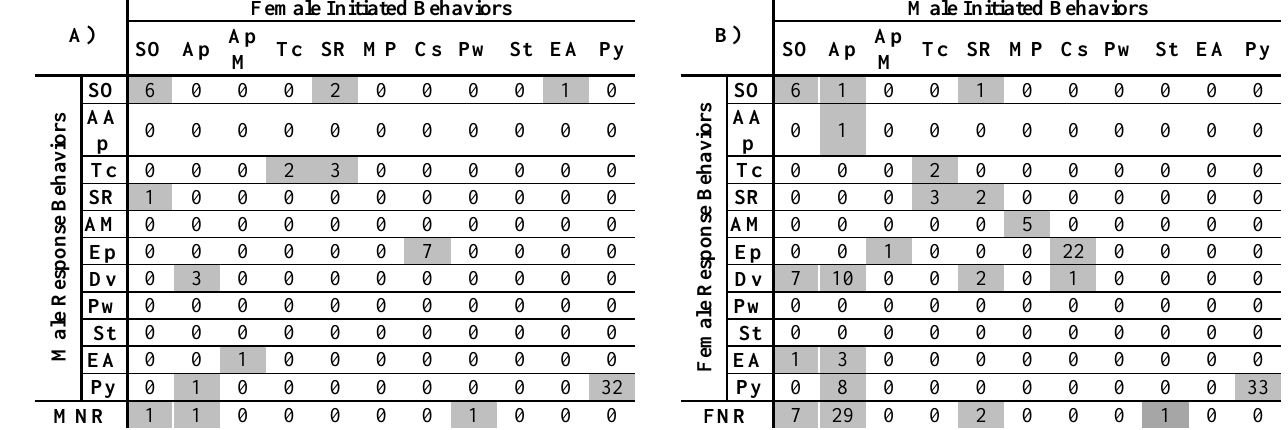
Figure 1. Interaction data sequences as frequencies of initiated/response behavior. A) Female initiated behaviors with male responses (62 times); B) Male initiated behaviors with female responses (115 times). SO - Smell the other; Ap – Approach; ApM - Approach with open mouth; Tc - Touch; SR – Social rubbing; MP – Mating position; Cs – Chase; Pw – Paw; St – Steal; EA – Expression antithesis; Py – Play; AAp – Avoiding approach; AM – Avoiding mating; Ep – Escape; Dv – Deviate; MNR – Male no-reaction; FNR – Female